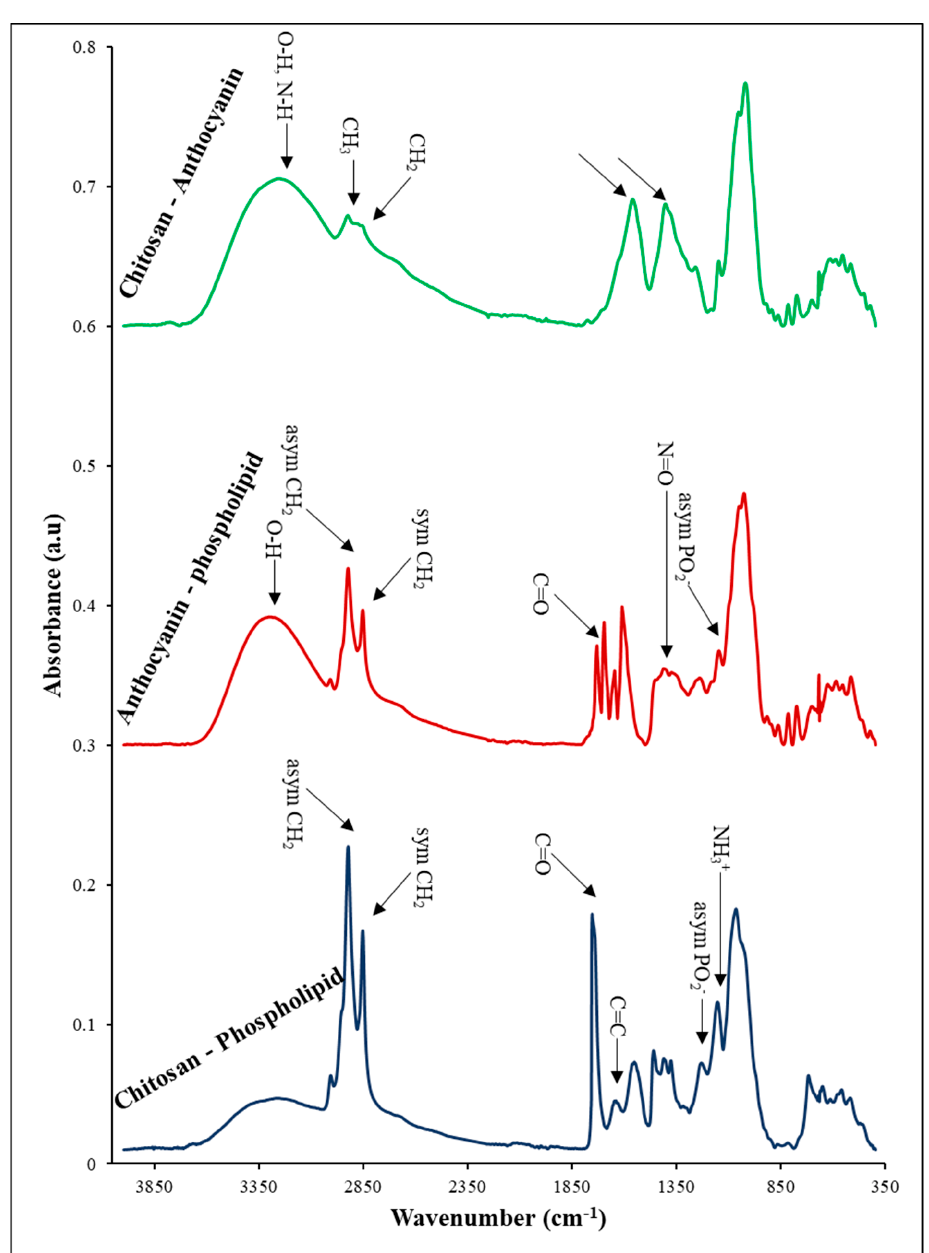
Figure 6. FTIR spectrum of chitosan-phospholipid, anthocyanin-phospholipid, anthocyanin-chitosan.